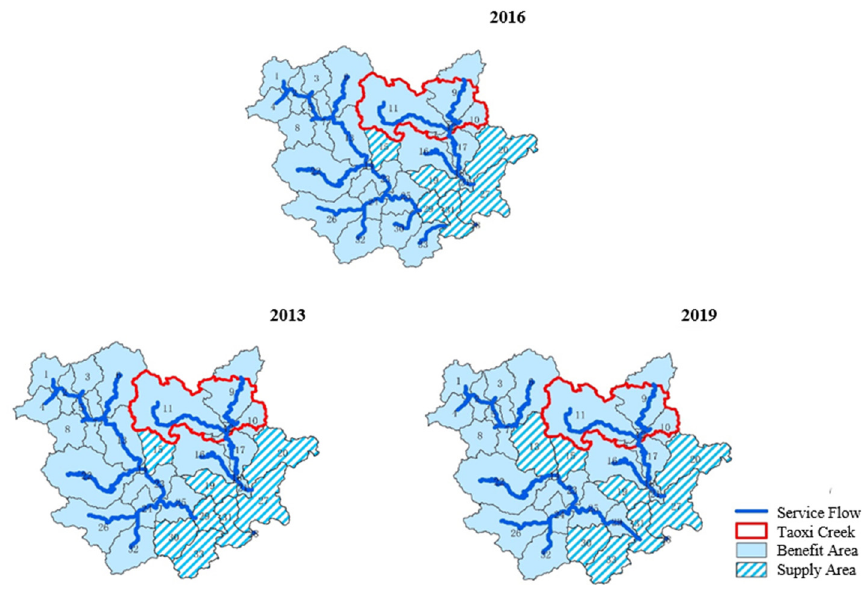
Figure 11. Balance of supply and demand of water resources and flow direction of ecosystem services in the Jinjiang watershed in 2013, 2016, and 2019.